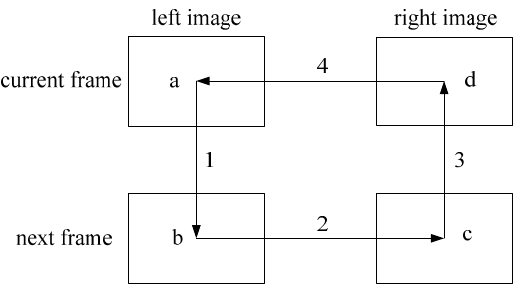
Figure 3. The process of a circle matching.